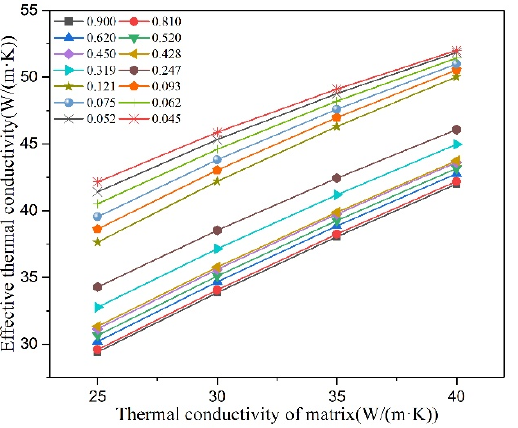
9 of 13 Figure 5. Effect of graphite volume fraction on effective thermal conductivity of cast iron, λ (cid:3040) = 25 W/(m·K).